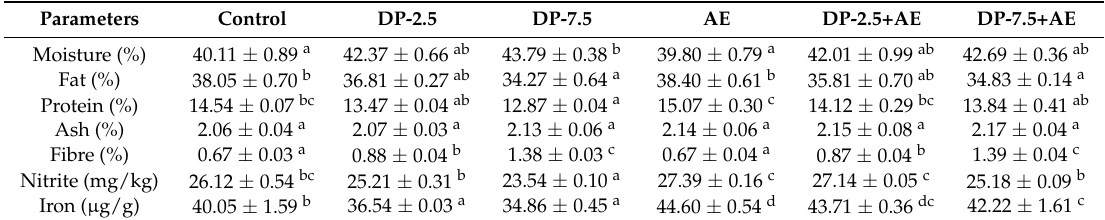
Table 1. Chemical composition of the different pork liver p â t é s with date paste (DP) (0%, 2.5%, and 7%) and annatto extract (AE) (0 and 128 mg/kg) (Mean ± Standard Error (SE)).